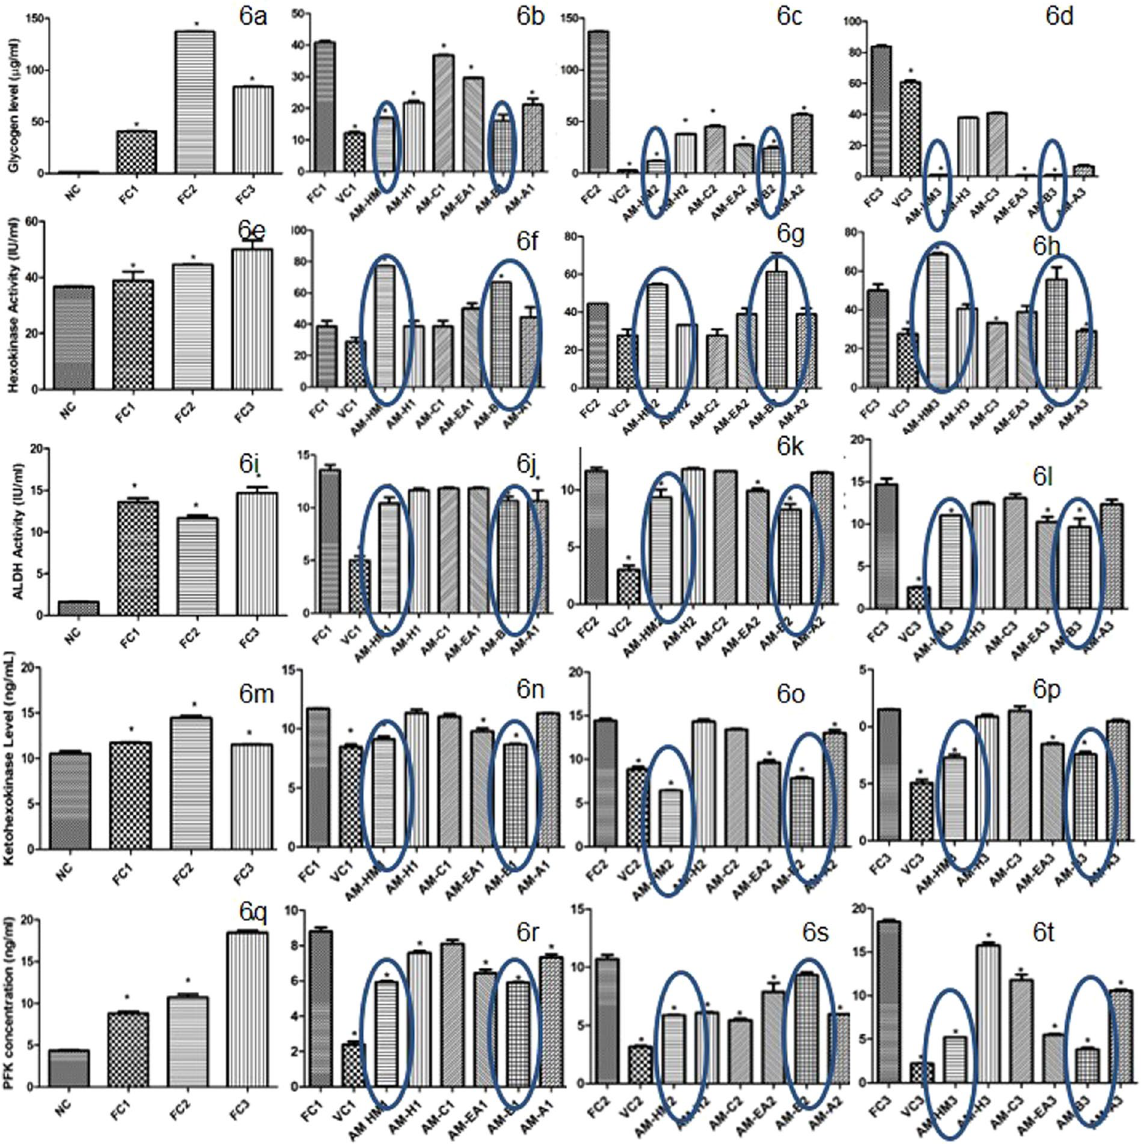
Figure 6. Effect of AM-HM on the milieu of sugar metabolizing enzymes of HepG2 when they are grown in fructose-rich media. Treatment of HepG2 cells grown in media either without glucose (NC) or with 0.55 mM fructose(FC1) or with 1 mM fructose (FC2) or with 1 mM fructose + 0.1 µ M Insulin (FC3) with AM-HM (75 µ g/ml), AM-H (75 µ g/ml), AM-C (75 µ g/ml), AM-EA (75 µ g/ml), AM-B (75 µ g/ml) or AM-A (75 µ g/ml) for 48 hours affected the glycogen content ( µ g/ml), activities of glycolytic enzymes-hexokinase (IU/ml), aldehyde dehydrogenase(IU/ml), ketohexokinase (ng/ml) and irreversible regulator of glycolysis-phosphofructokinase (ng/ml). The AM-HM and AM-B reduced the glycogen level in FC1 & FC2 and the effect was augmented by insulin in FC3. The AM-HM and AM-B potentiated the action of HK in FC1 & FC2 and the effect was augmented by insulin in FC3. The AM-HM and AM-B reduced the activities of ALDH, KHK and PFK in FC1 & FC2 and the effect was augmented by insulin in FC3. Each value is the mean ± SD of n = 3. * p < 0.05 vs control using student- t